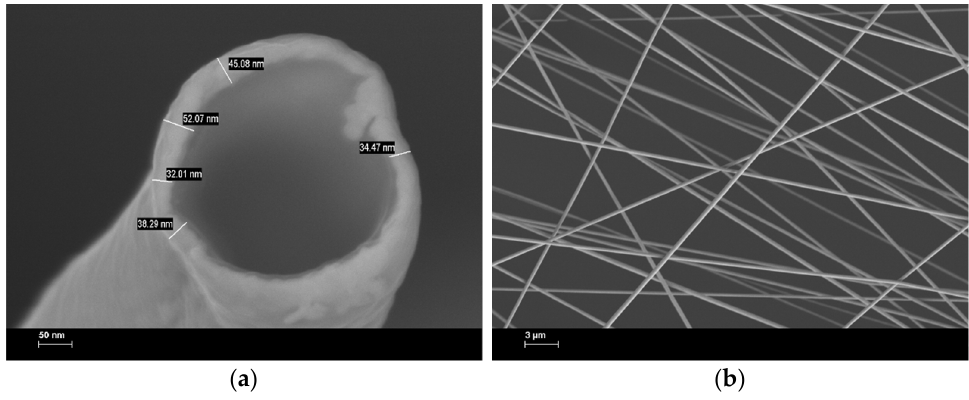
Figure 2. SEM images of electrospun gold cathodes ( a ) Cross-section at 300 kX; ( b ) Planar view at 5